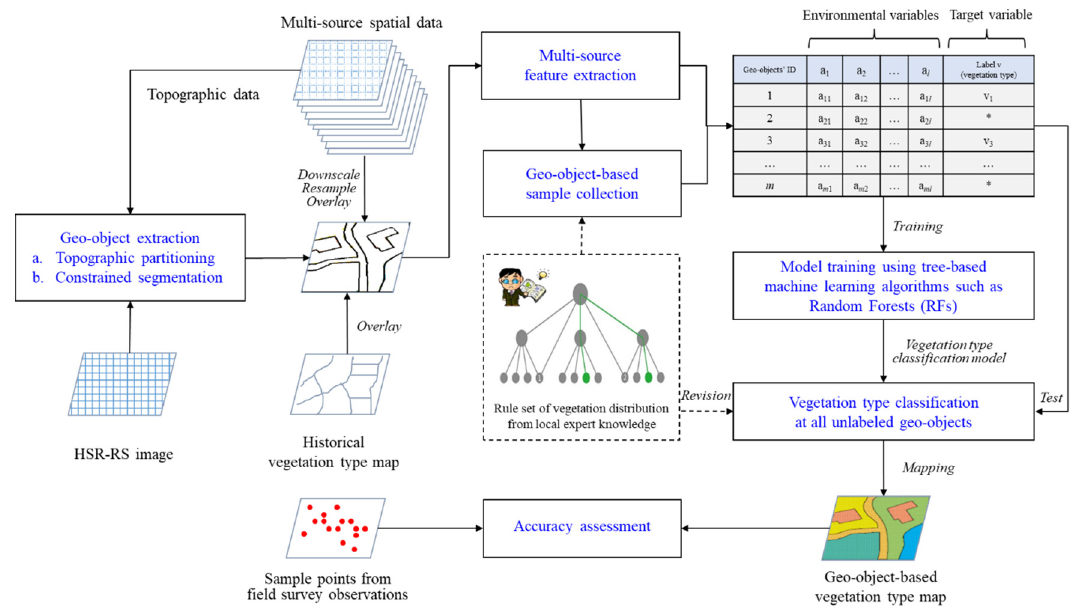
Figure 1. Flow chart of the proposed procedure for geo-object-based vegetation mapping in mountainous areas.